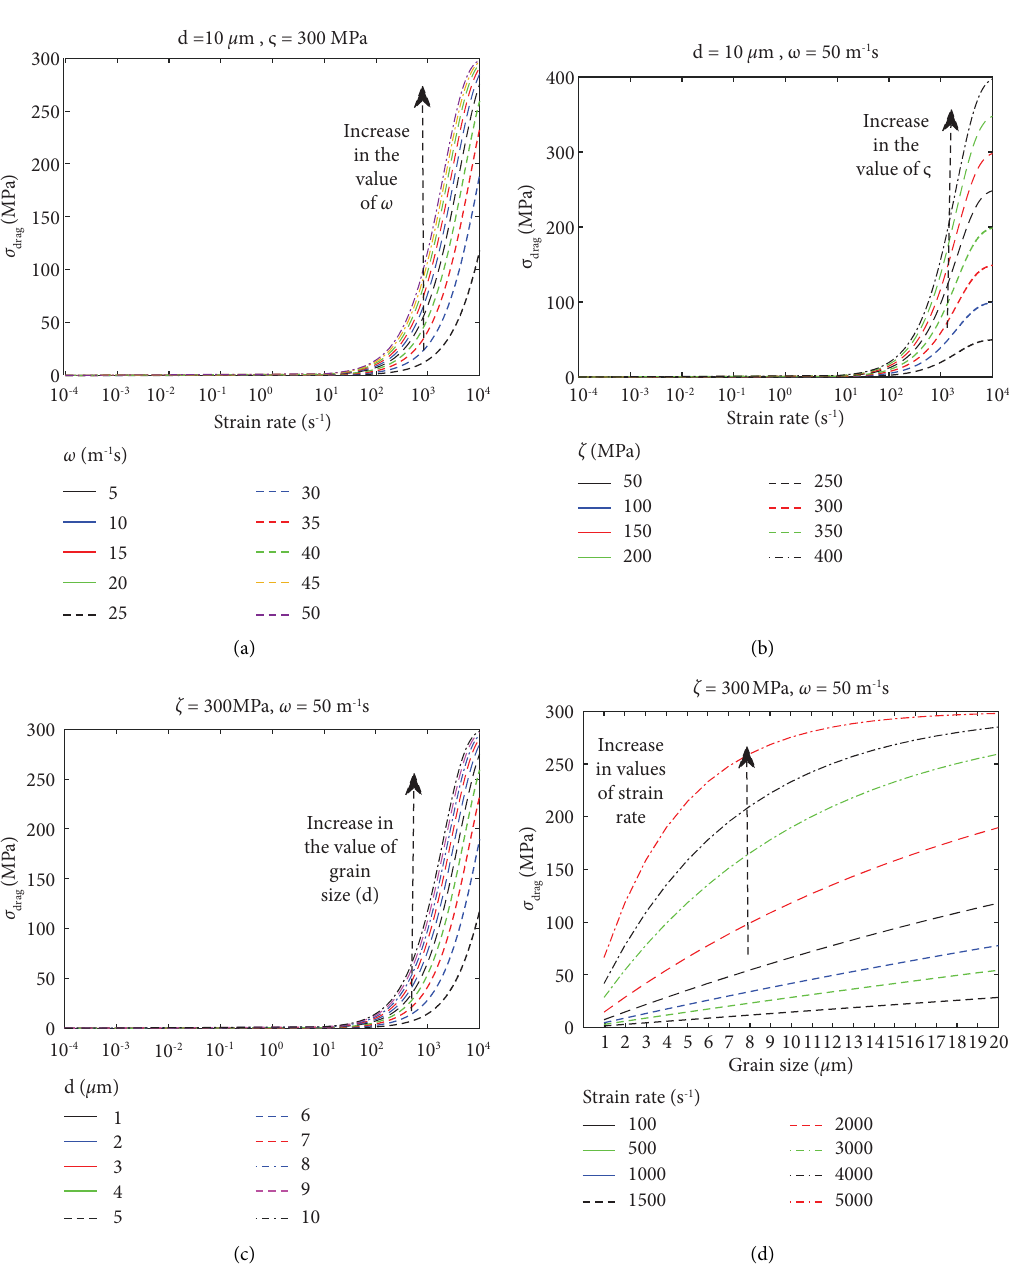
Figure 7: Te efects of various model parameters (a) ω , (b) ζ , (c) grain size, and (d) strain rate on viscous drag